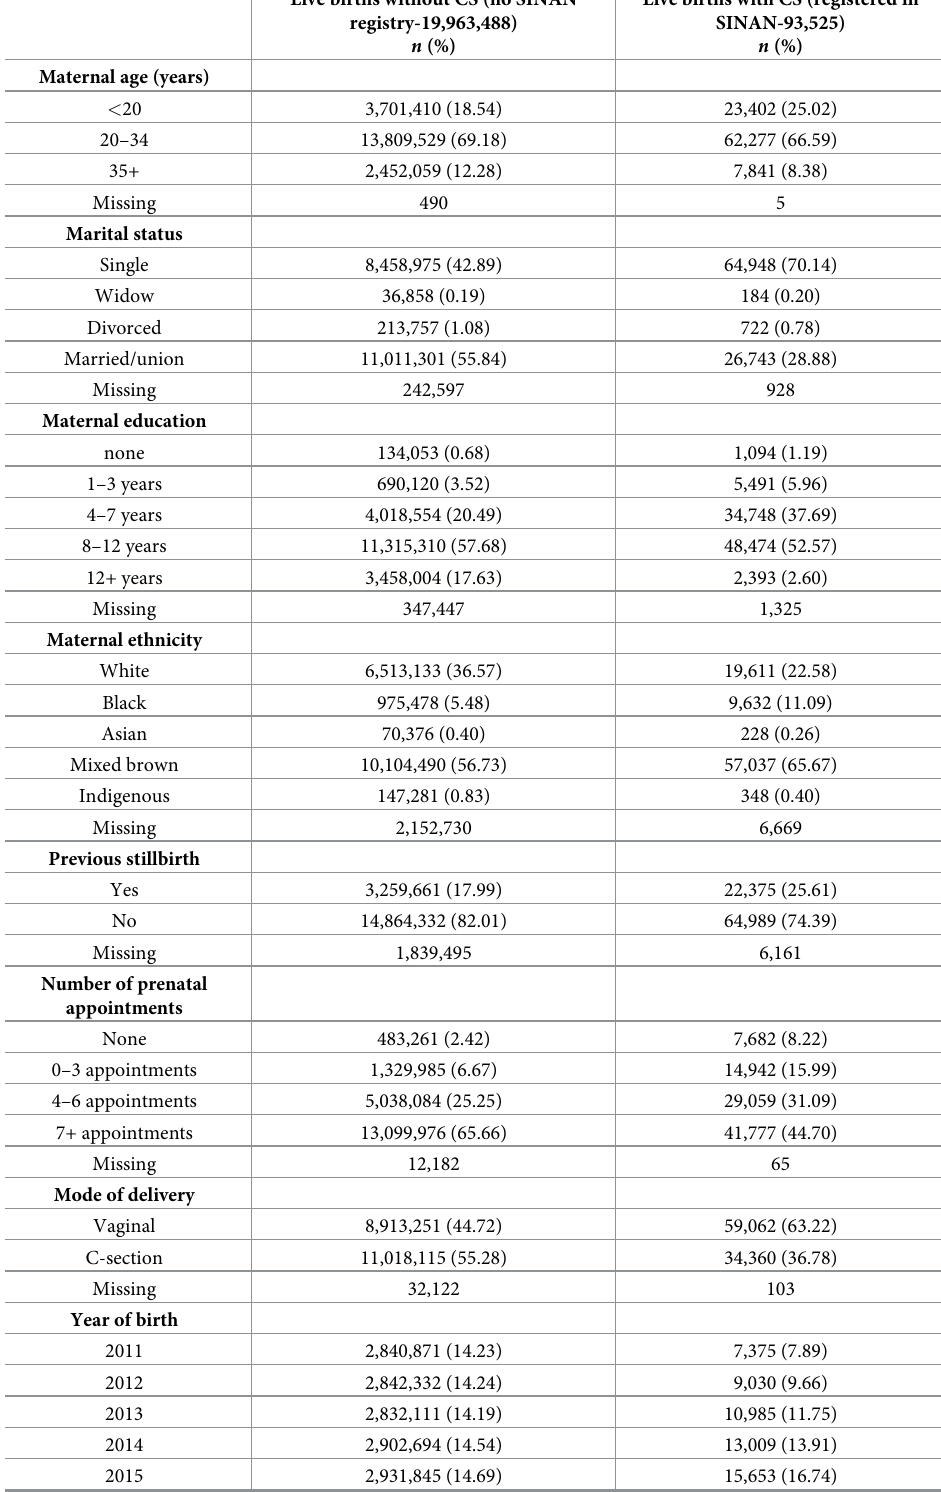
Table 1. Baseline characteristics of 20,057,013 singleton live births in the cohort-linked data by CS status. Live births without CS (no SINAN Live births with CS (registered in registry-19,963,488) n (%)